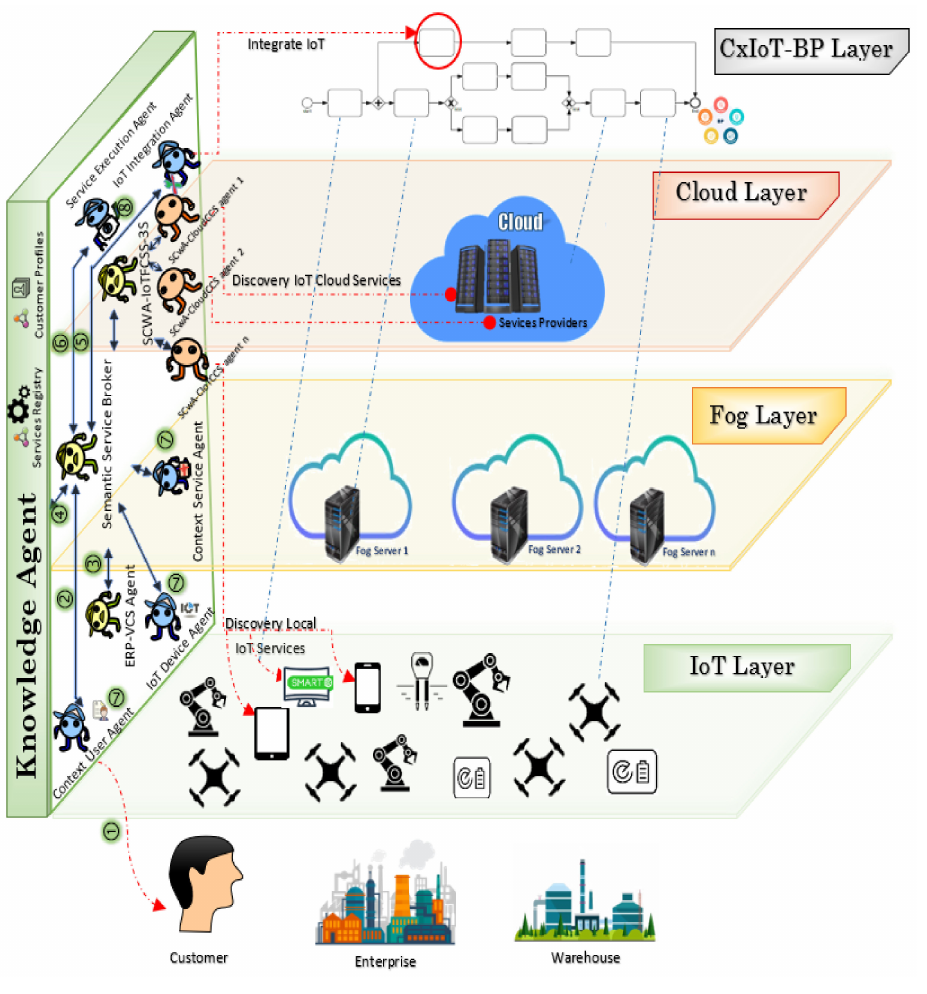
Figure 9. An overview of the proposed